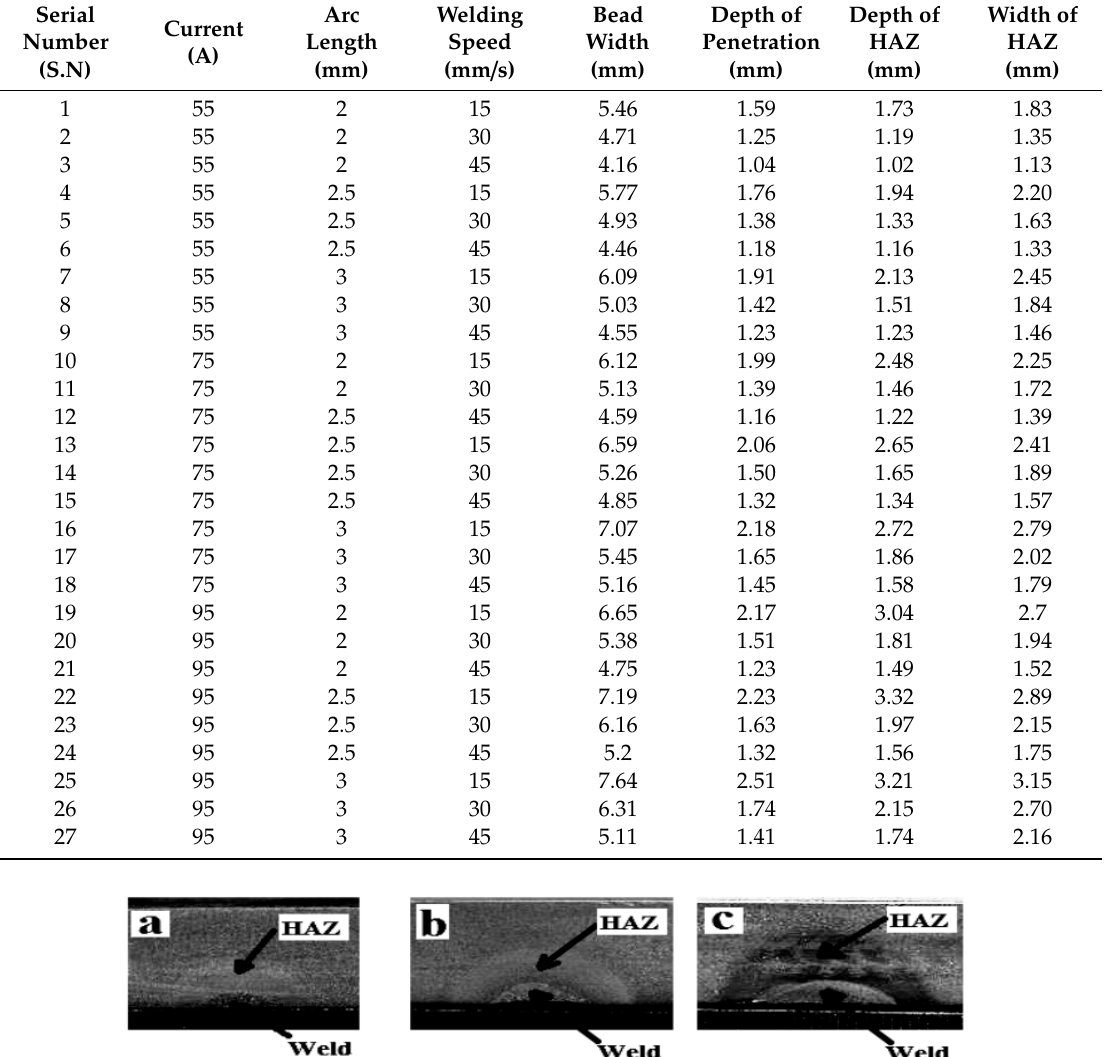
Figure 8. Experimental set-up of the TIG welding process.